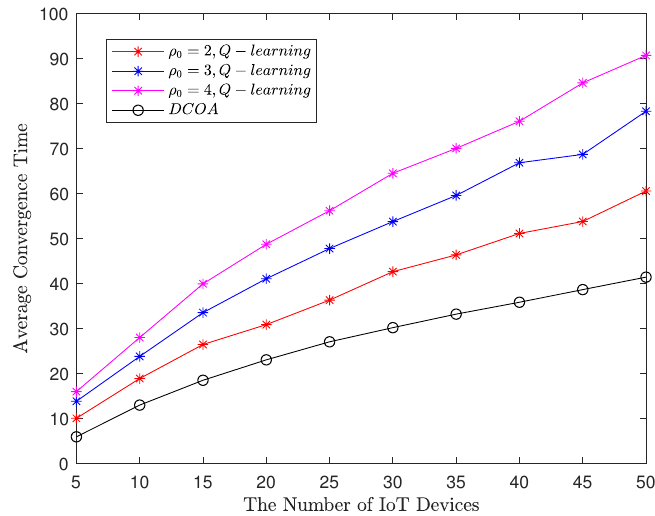
Figure 6. Convergence time of the Q-learning with Boltzmann learning policy and distributed computation offloading algorithm